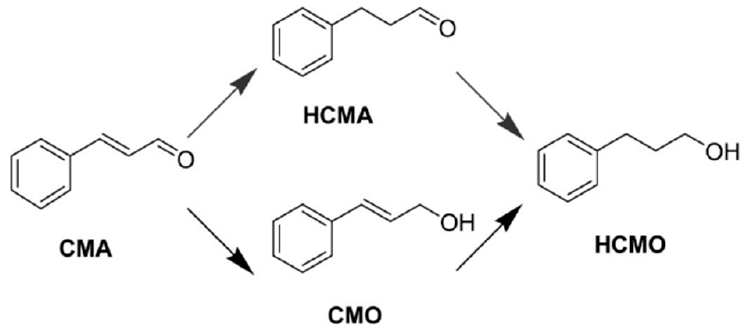
Figure 3. Modes of FFR adsorption on catalyst surfaces. Adapted from [70].